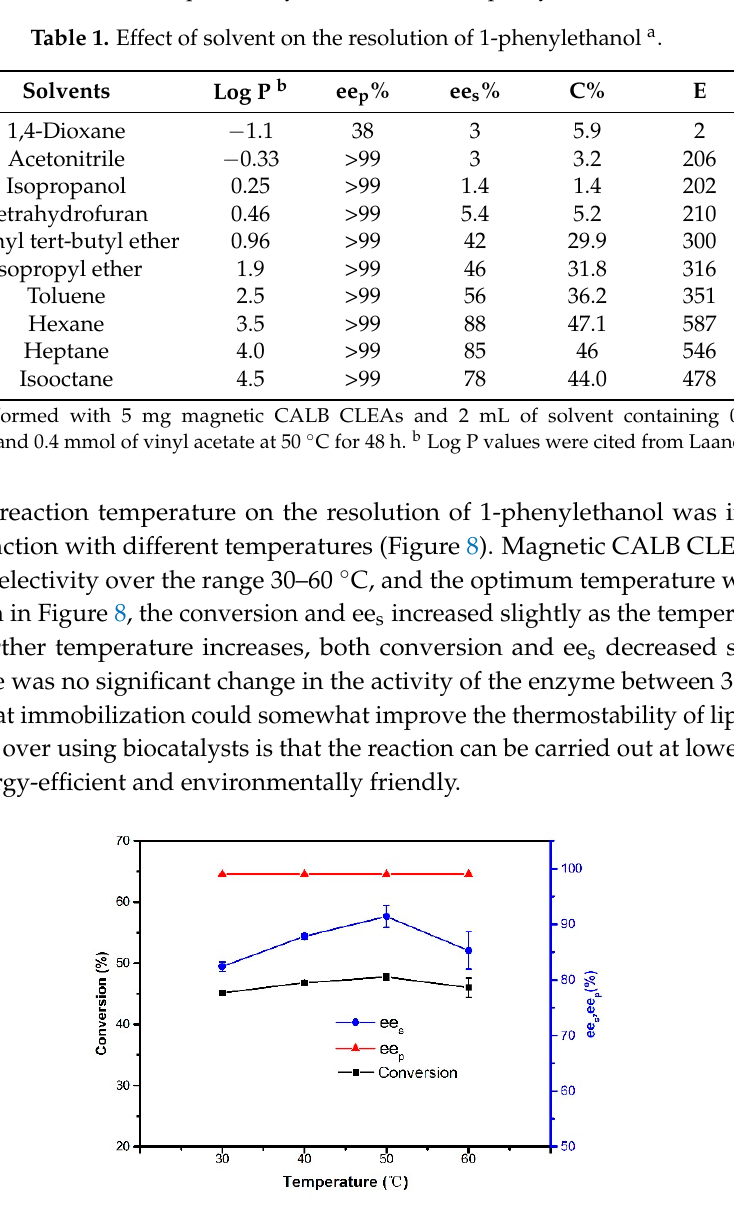
Figure 8. Effect of temperature on the resolution of 1-phenylethanol. Reactions performed with 5 mg magnetic CALB CLEAs and 2 mL of n-hexane containing 0.2 mmol of 1-phenylethanol and 0.4 mmol of vinyl acetate for 48 h.